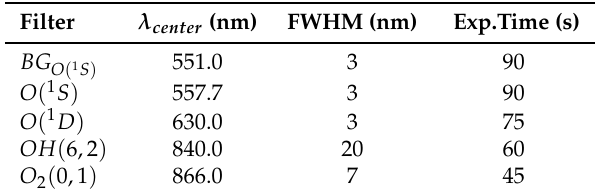
Figure 1. OH ( left ) and O ( 1 S ) ( right ) nightglow emission images taken on 19 January 2015 at 0116 UTC and 0117 UTC. These images were not preprocessed to show the fisheye lens distortion of the night sky. Without preprocessing, the image field of view is about 1500 km 2 . Both images were captured with the Andes Lidar Observatory (ALO) all-sky imaging system (ASI-1). Table 1. ALO nightglow imager (ASI-1) filter wheel configuration along with the full width at half maximum (FWHM) and exposure time. The O ( 1 S ) and OH ( 6,2 ) filters were used here to estimate wave amplitudes in airglow